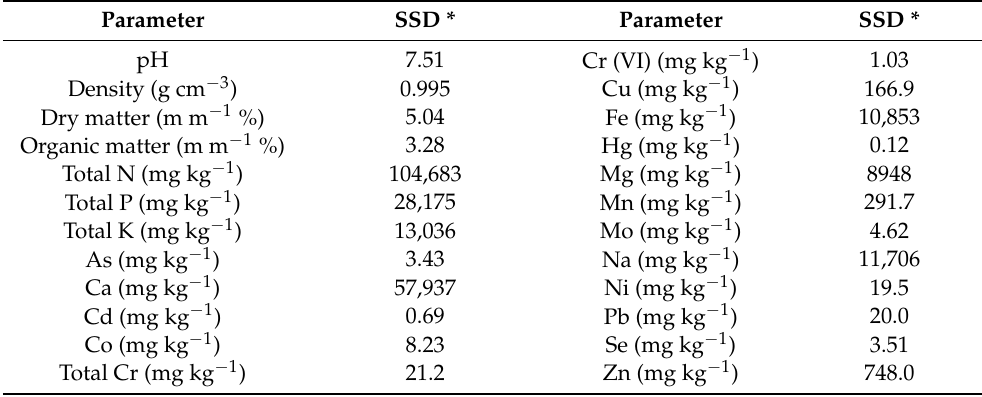
Table 2. The basic chemical properties of the applied